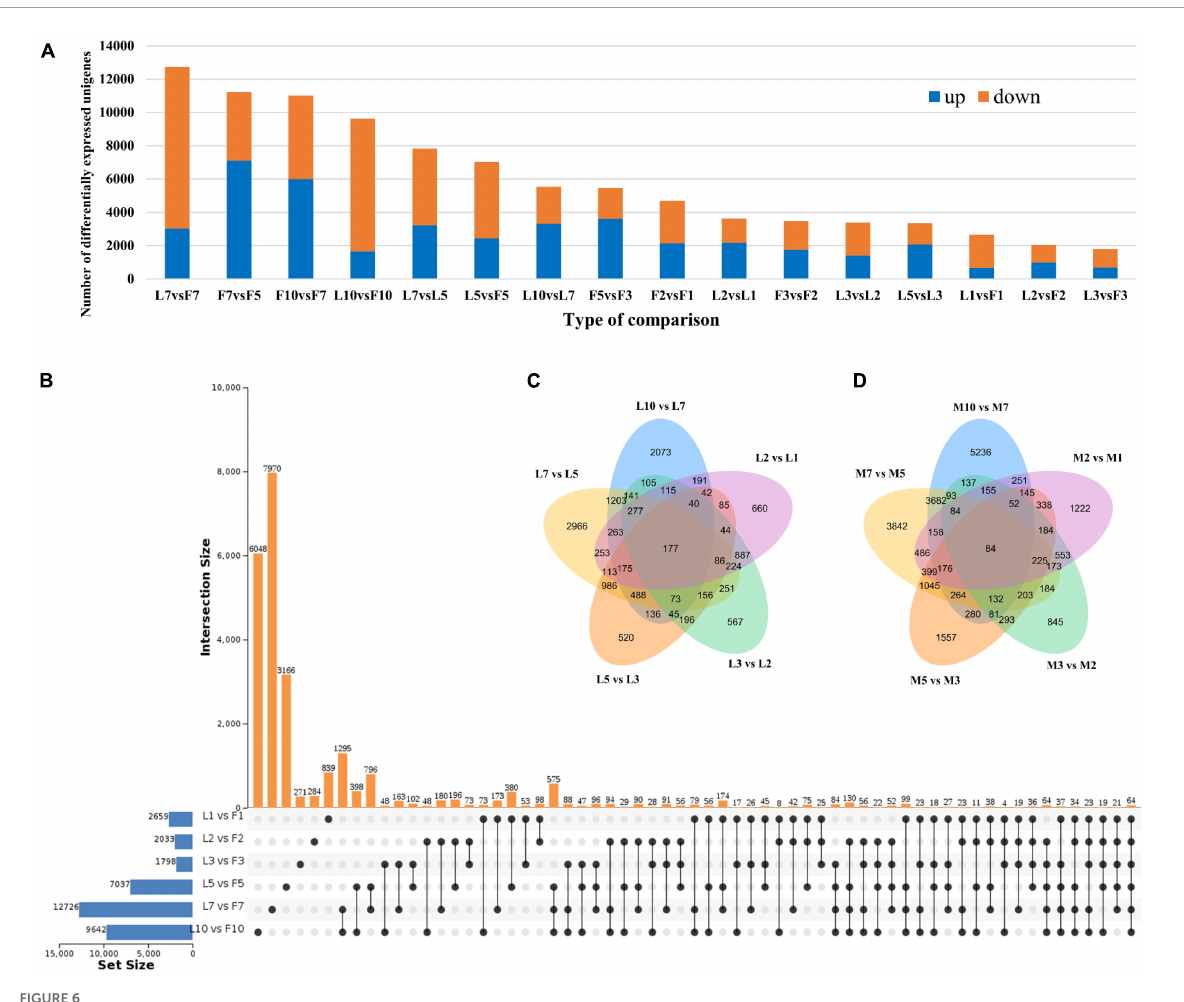
FIGURE6 (A) Distribution of differentially expressed Dacrydium pectinatum unigenes identified in various comparisons. Venn diagram of differential unigenes in L vs. F (B) , L vs. L (C) , M vs. M (D) . L, leaves; F, female cones. 1: January, 2: February, 3: March, 5: May, 7: July, 10: